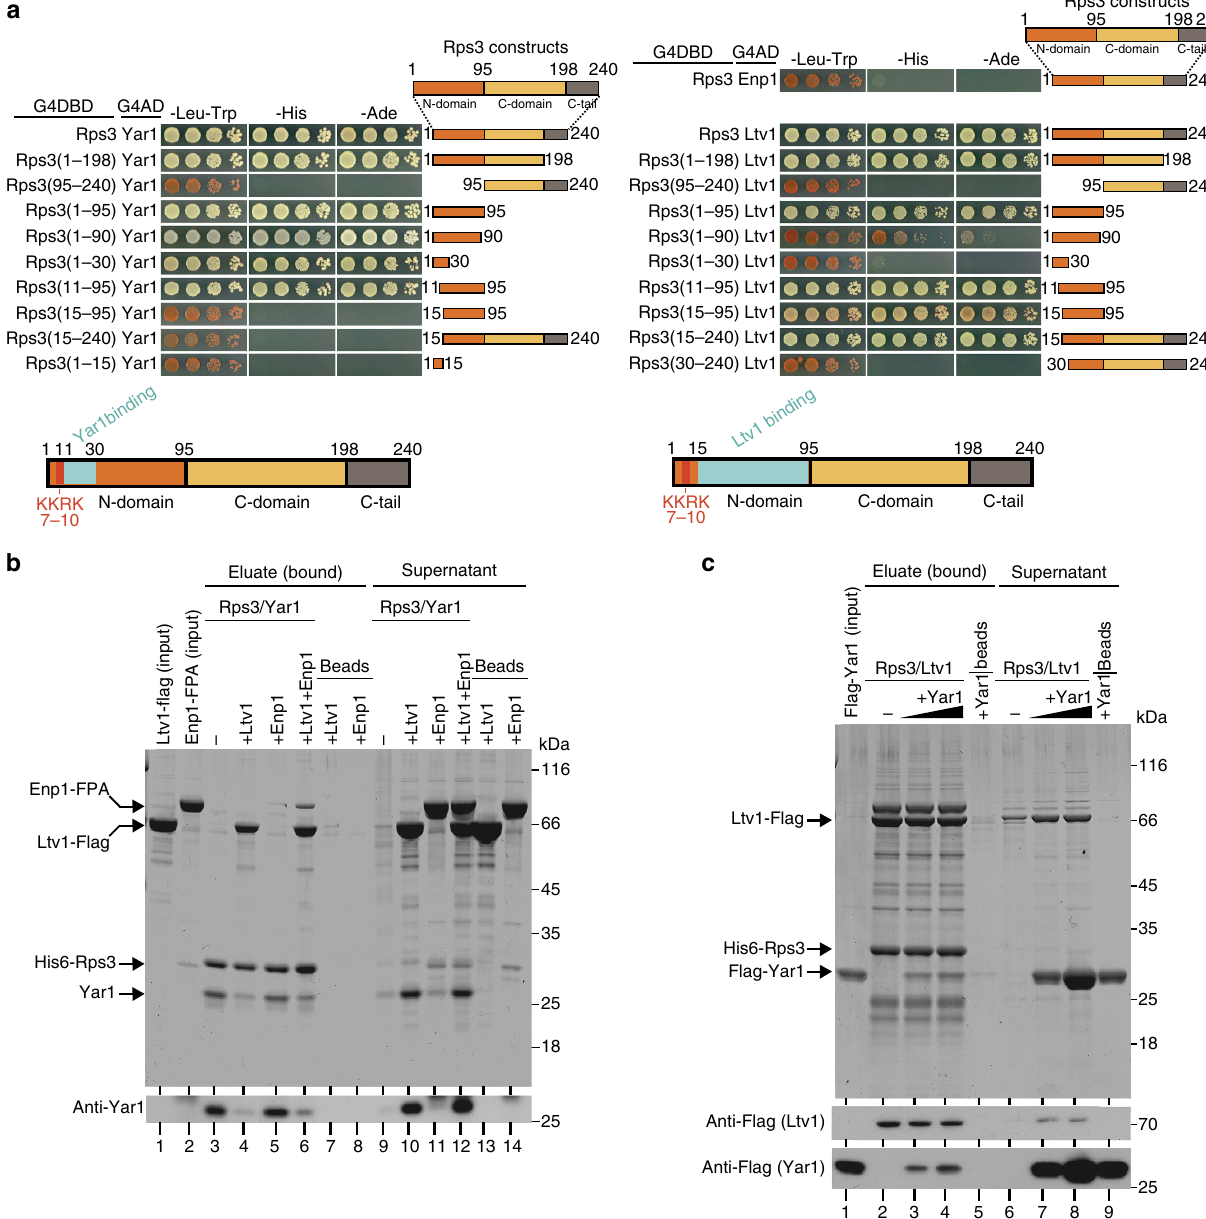
predominantly found in the soluble fraction (Fig. 4f). Notice- ably, the assembly factors Rio2 and Tsr1 also accumulated on pre-ribosomes in the ltv1 (S336A/S339A/S342A) mutant (Fig. 4f), supporting the idea that the phosphorylation- dependent Ltv1 release is a prerequisite for downstream